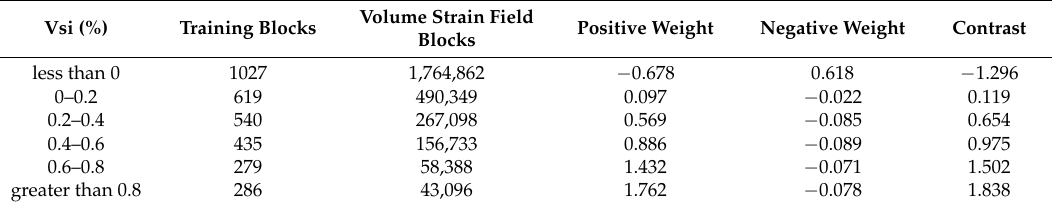
Table 3. Weights for different spaces of volume strain field at 0.2% intervals.